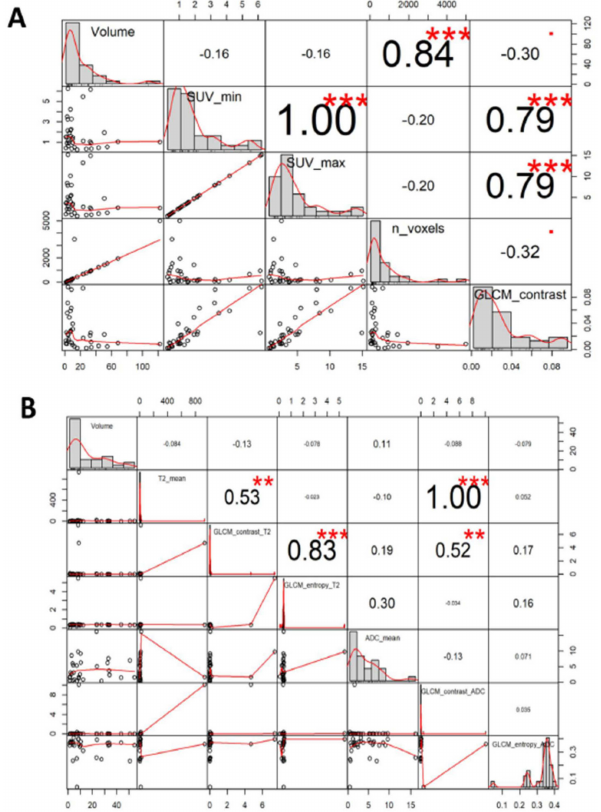
Figure 6. Correlation matrix for radiomics features of PET and MRI images. Correlation charts represent the correlation matrix between the statistical and textural parameters extracted from PET images ( A ) and MRI images ( B ) mostly used for breast lesions. The distribution of each variable is shown on the diagonal. On the bottom of the diagonal: the bivariate scatter plots with a fitted line are displayed. On the top of the diagonal: the value of the correlation plus the significance level as stars. Each significance level is associated to a symbol: p values 0.001; 0.01; 0.05; with symbols “***”; “**”; “*”